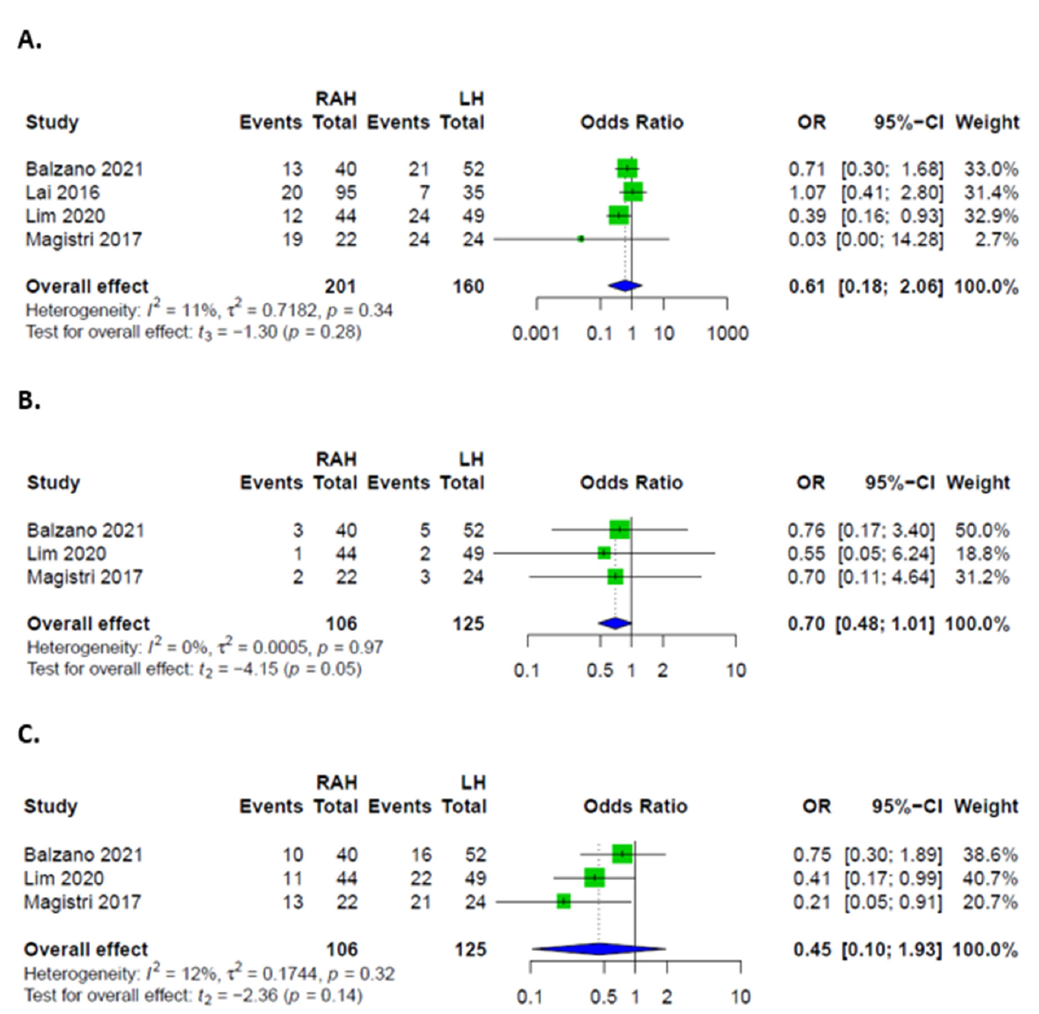
Figure 3. Forest plots for complications; ( A ) Overall complications in patients after RAH and LH; ( B ) Major complications in patients after RAH and LH; ( C ) Minor complications in patients after RAH and LH.